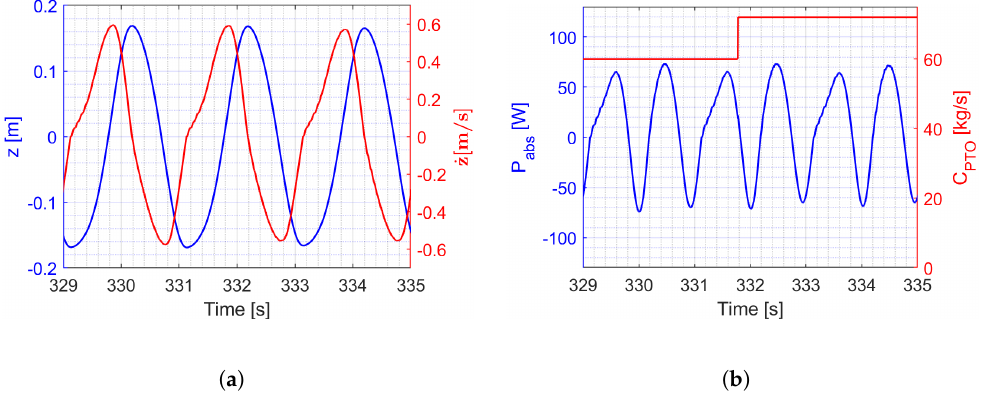
Figure 20. Reactive control test (Test_138): ( a ) z and ˙ z time series; ( b ) P abs and C PTO time